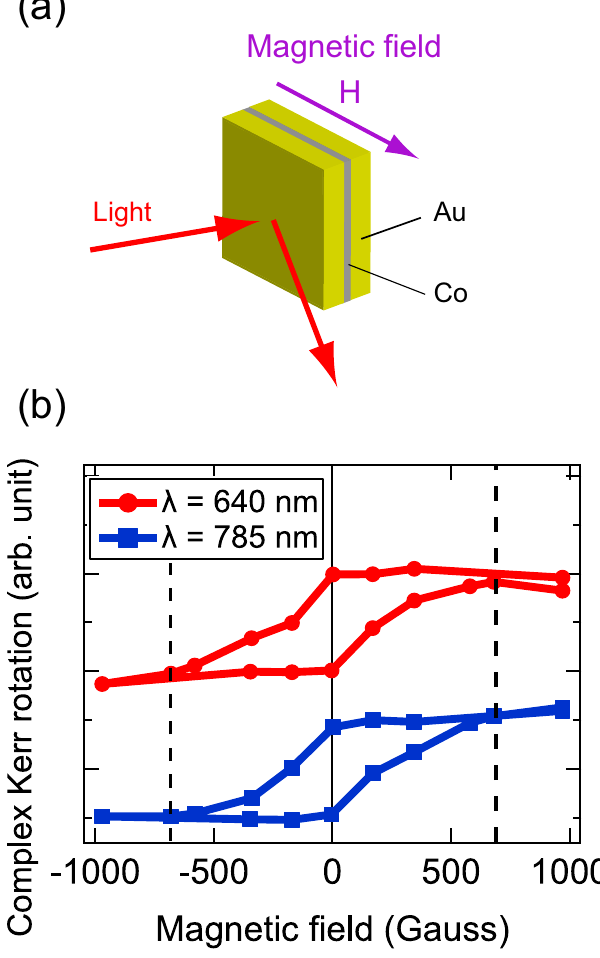
Figure 2. ( a ) Longitudinal magneto-optical Kerr effect (L-MOKE) measurement configuration. Magnetic field (H) is applied parallel to the surface of the Au/Co/Au nanostructure. ( b ) Magnetic field dependence of normalized complex Kerr rotation in longitudinal configuration (L-MOKE curve) for Au/Co/Au nanostructure at two different incident wavelengths ( λ ): 640 nm – off-resonance (red circles and line) and 785 nm – on- resonance (blue squares and